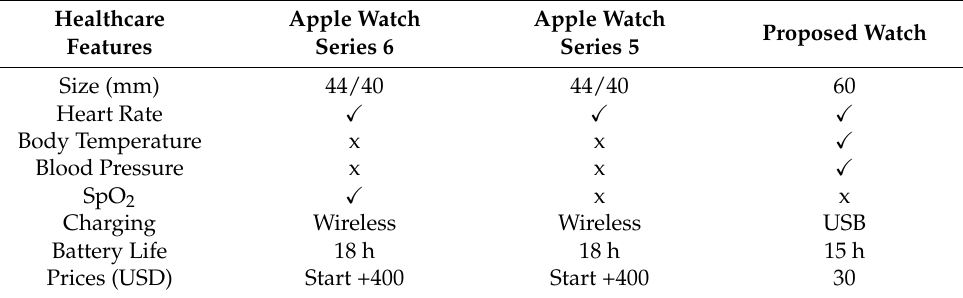
Table 4. Cost and battery life comparisons between commercial and proposed smart wearable